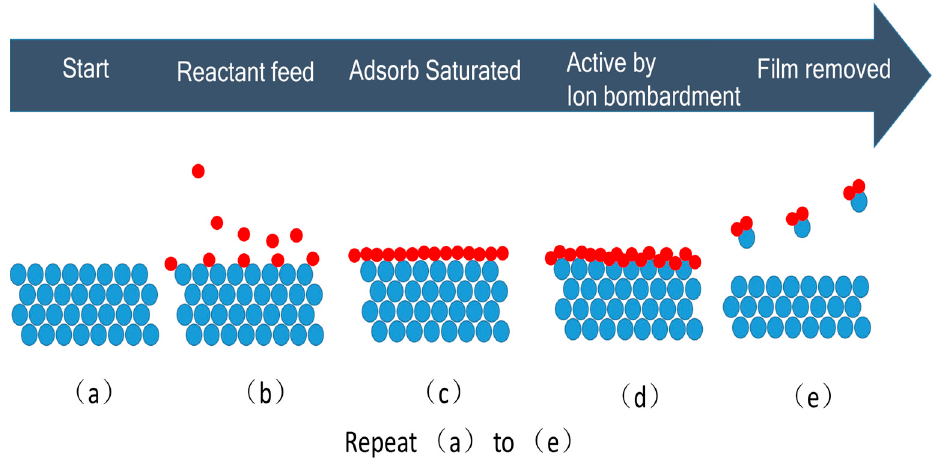
Figure 15. The concept of Quasi-ALE with (a) process started, (b) reactant feed deposited, (c) adsorb saturated, (d) active by Ion bombardment and (e) film removed.